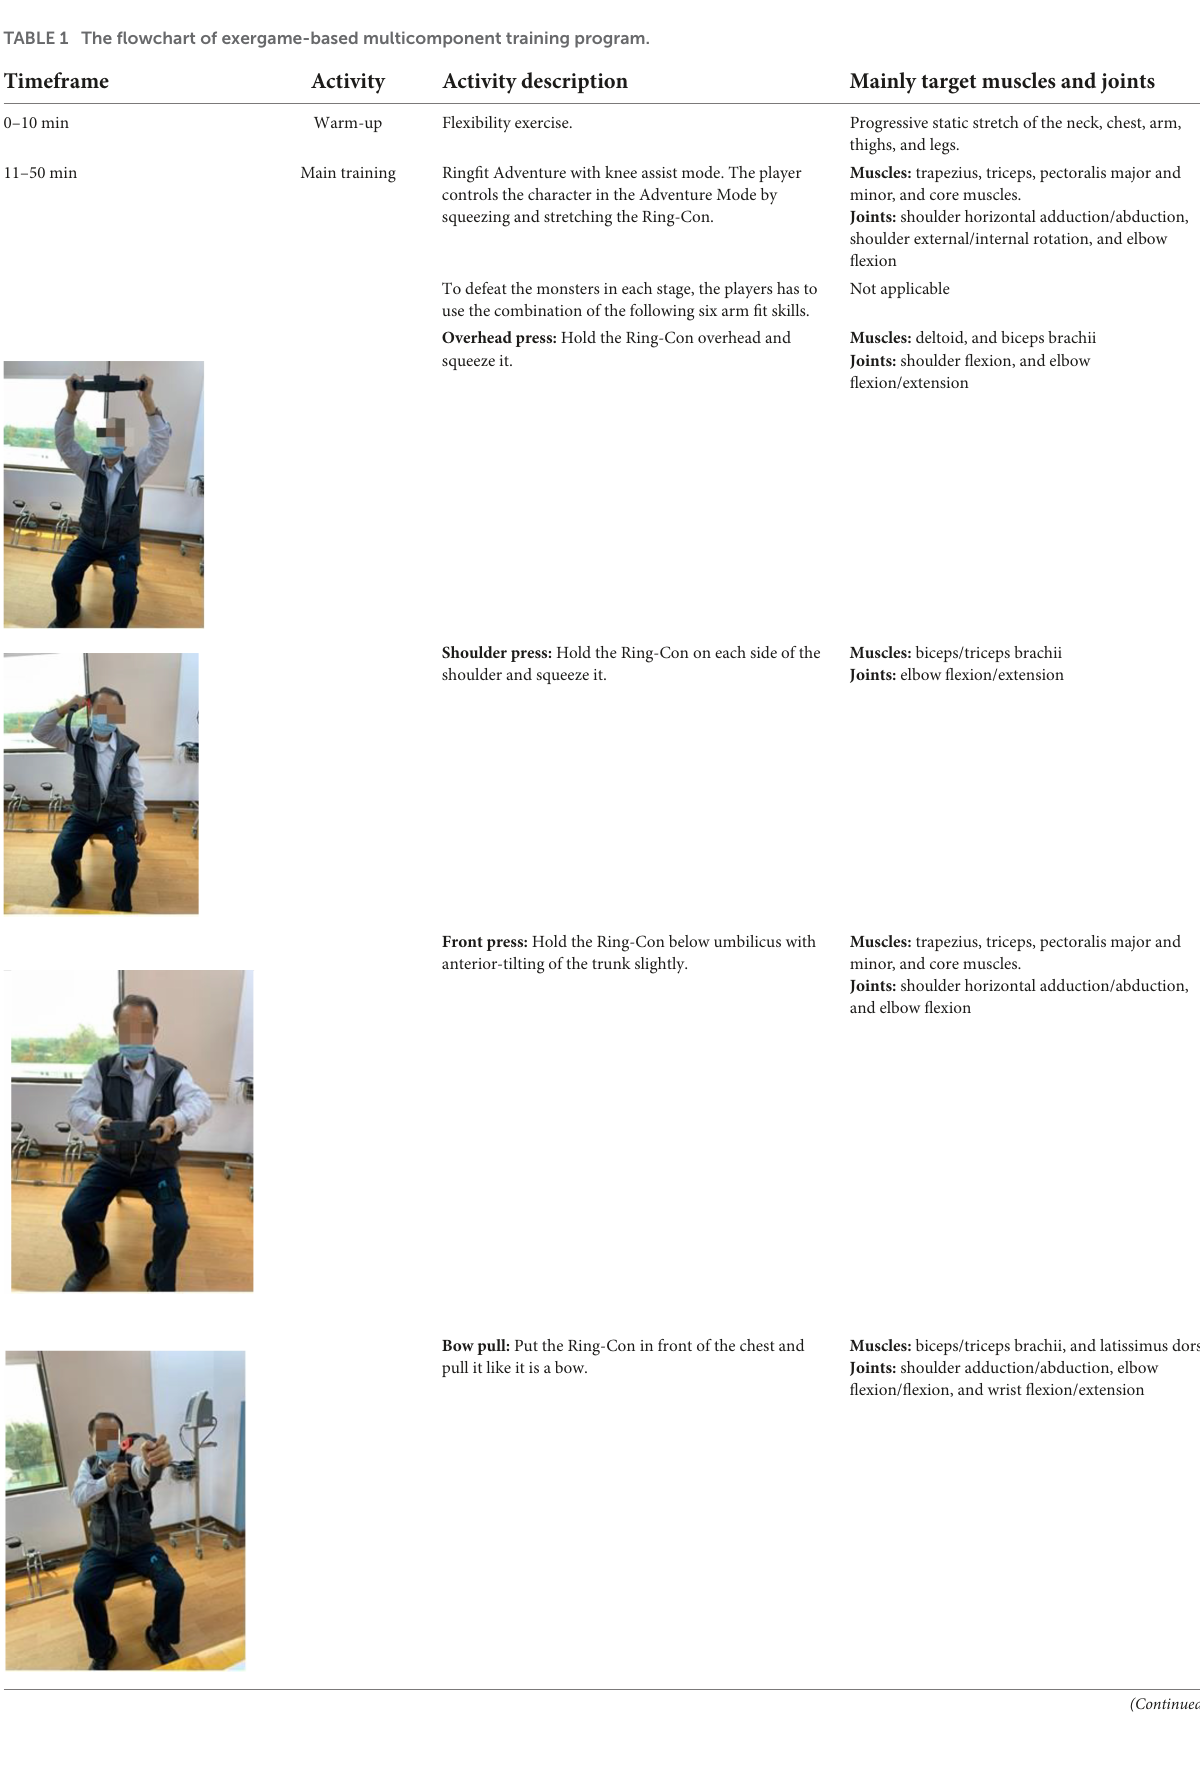
TABLE 1 The flowchart of exergame-based multicomponent training program.